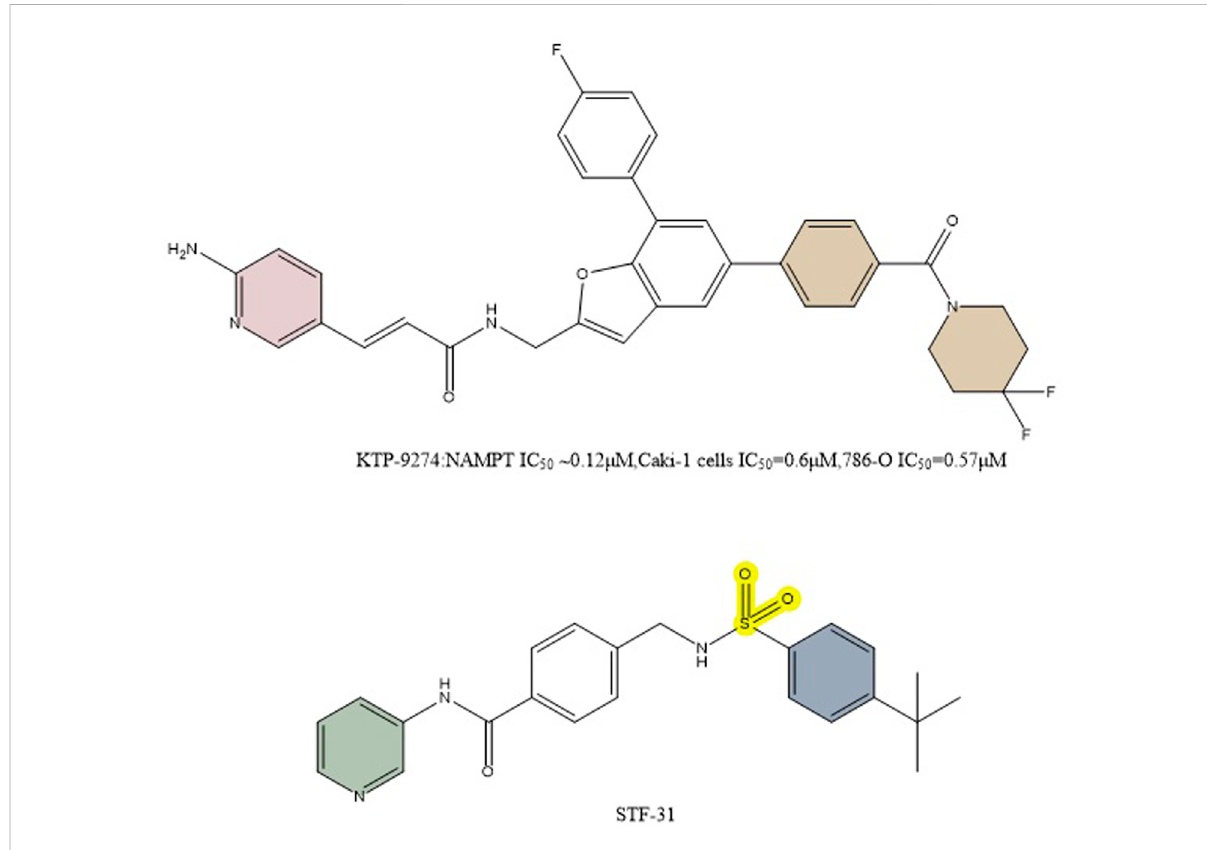
FIGURE 10 Structure of dual inhibitors KPT-9274 and